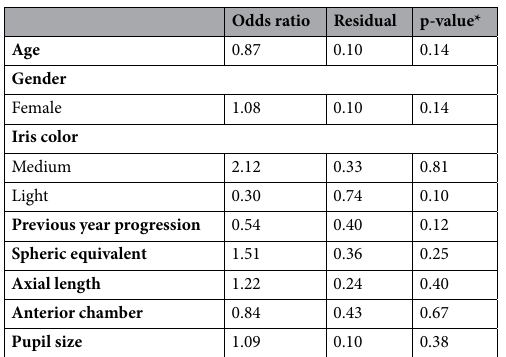
Table 3. Progression risk factor analysis for spherical equivalent more than − 0.50 diopters. *Multi variable logistic regression analysis and Huber-White robust standard